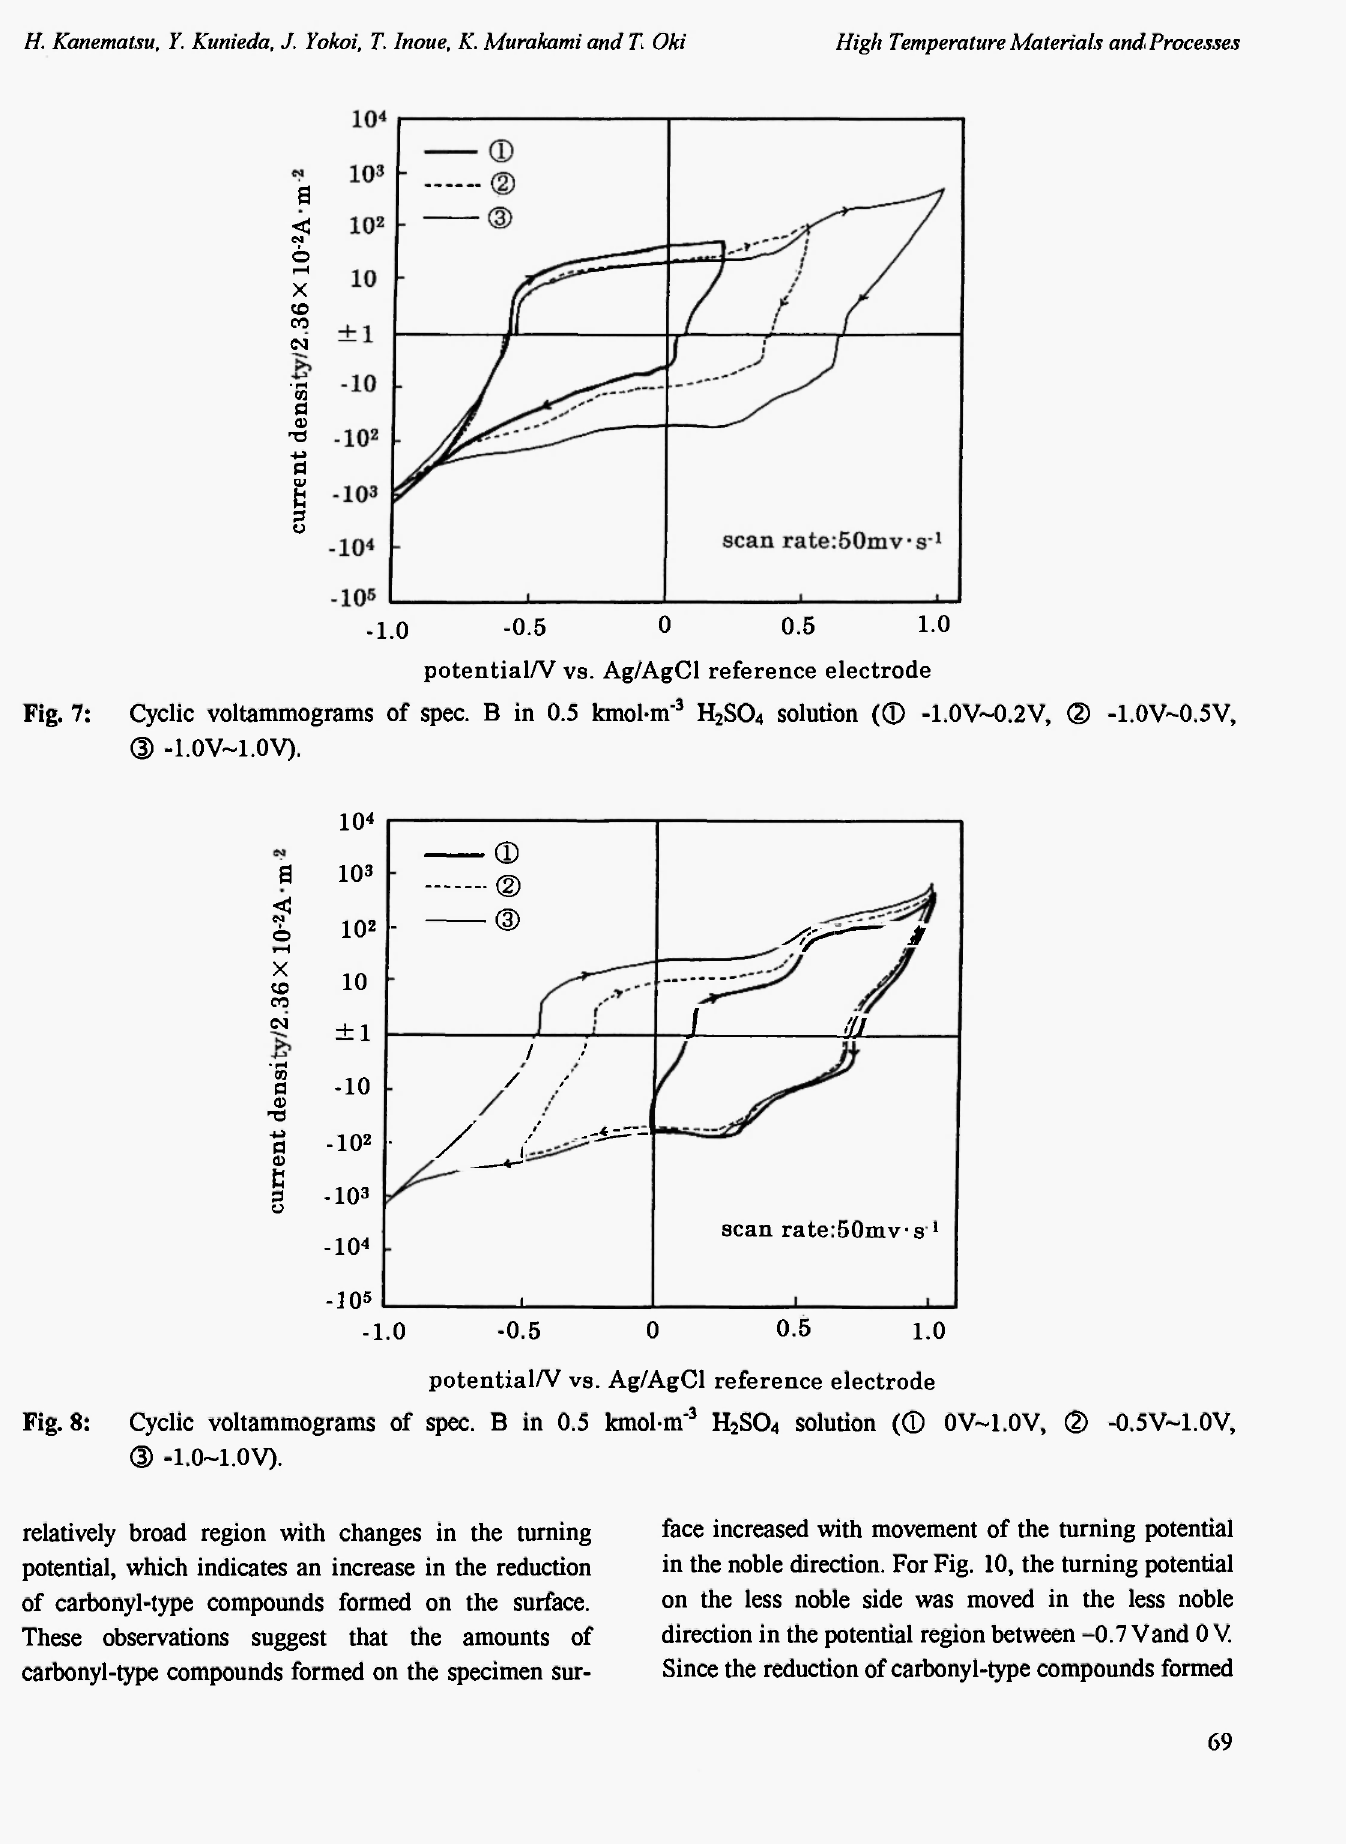
-1.0 -0.5 0.5 1.0 potential/V vs. Ag/AgCl reference electrode Cyclic voltammograms of spec. Β in 0.5 kmol-m" 3 H Fig. 8: (D